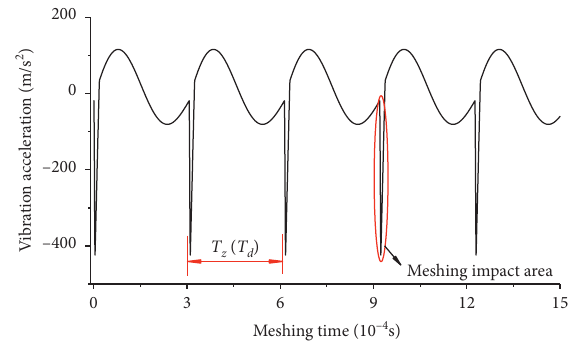
Figure 17: Time domain diagram of single-stage helical gear transmission under excitation of meshing impact at